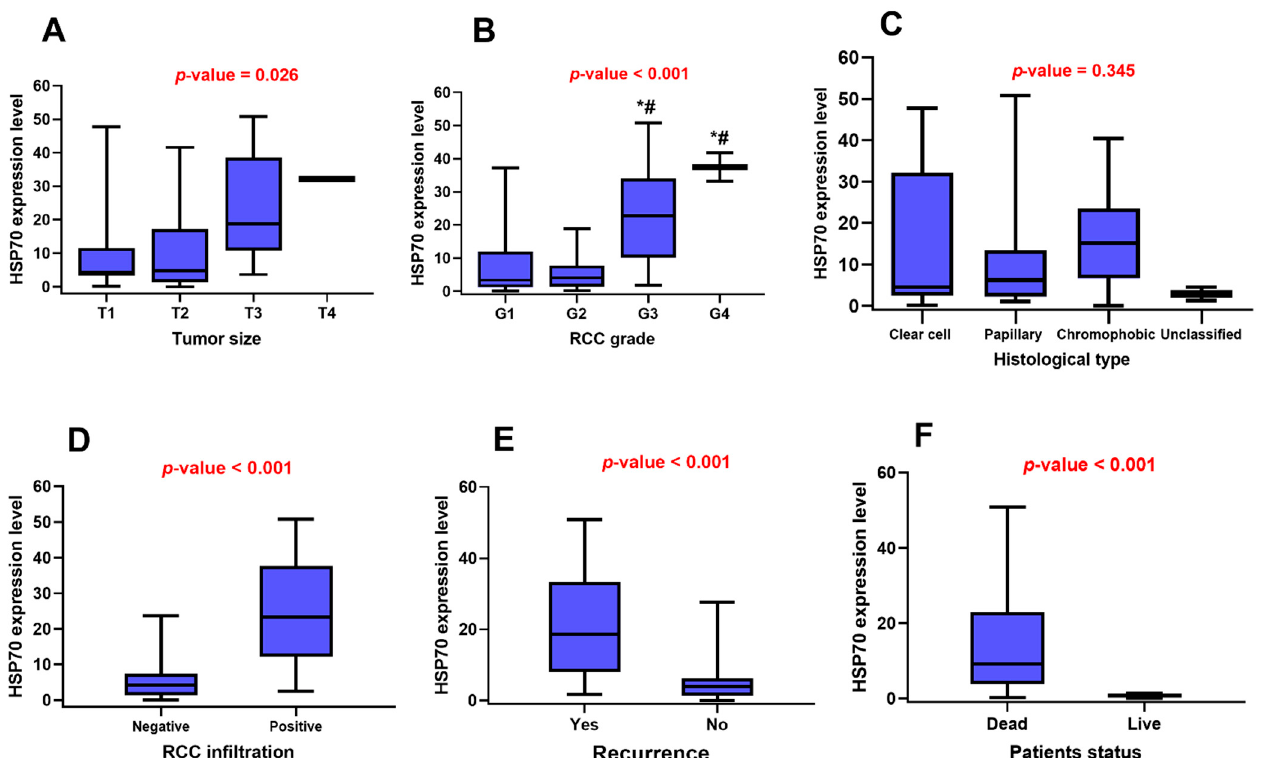
Figure 3. Association of HSP70 gene expression with clinicopathological characteristics. ( A ) Tumor size, ( B ) Pathological grade, ( C ) Histological subtype, ( D ) Capsular infiltration, ( E ) Recurrence, and ( F ) Mortality. Mann–Whitney U and Kruskal–Wallis tests were used for comparison. p -value < 0.05 was considered statistically significant. * Significance versus G1, # Significance versus G2.